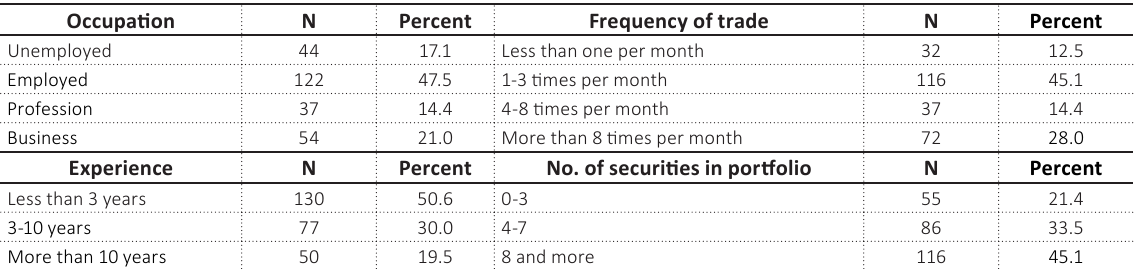
Table 2. Reliability of questionnaire statements